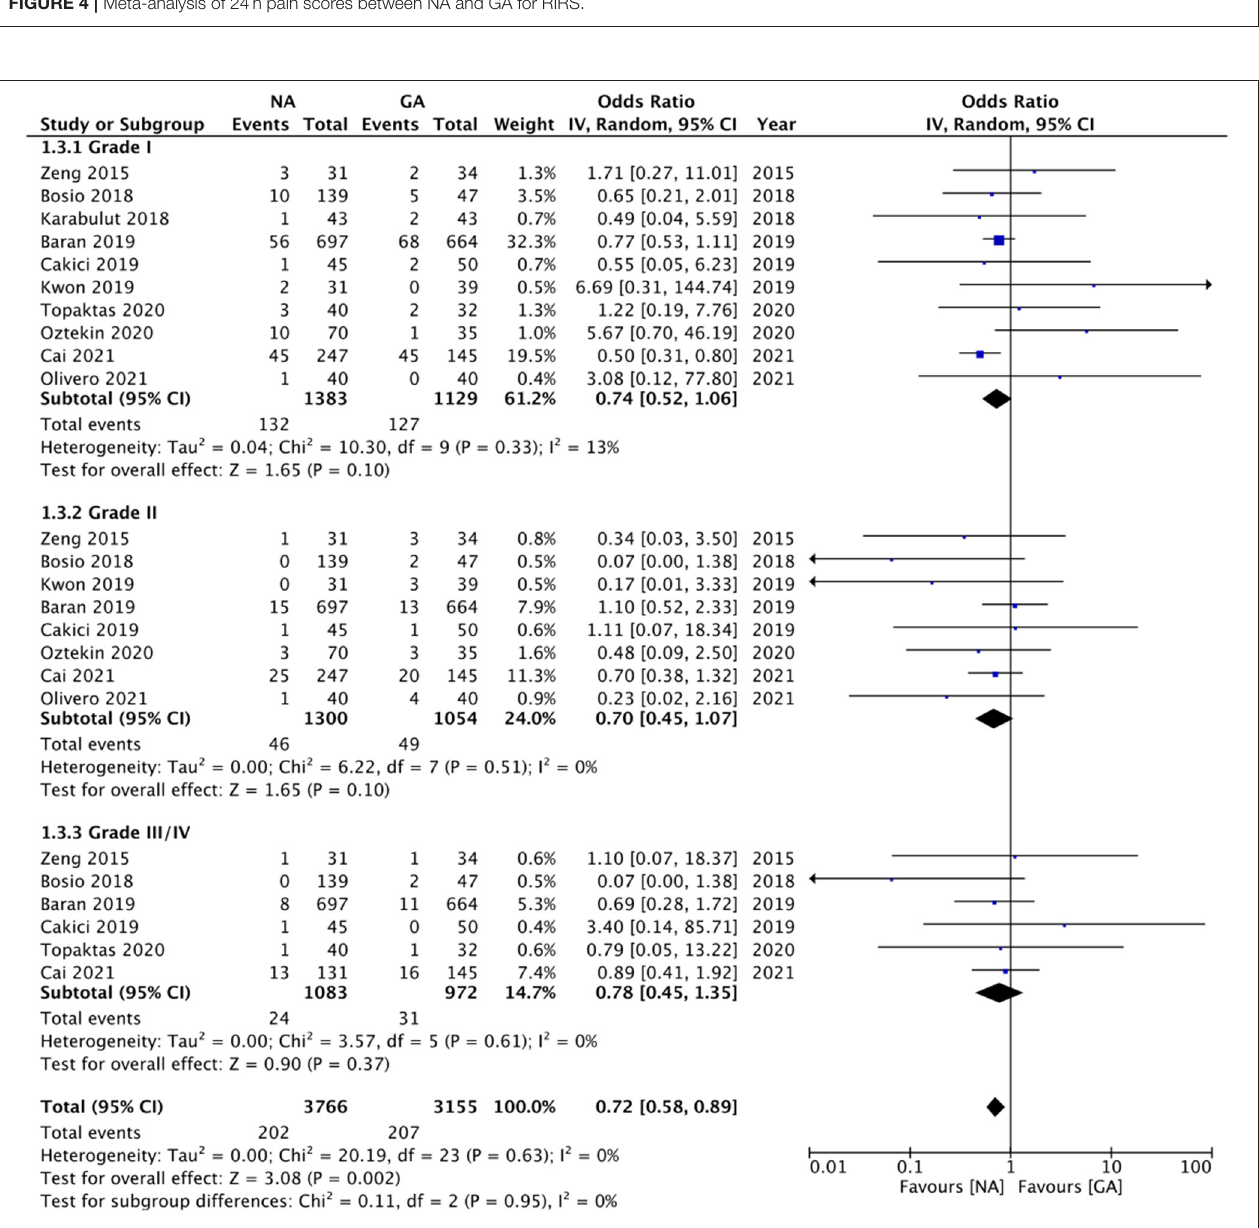
Frontiers in Surgery |